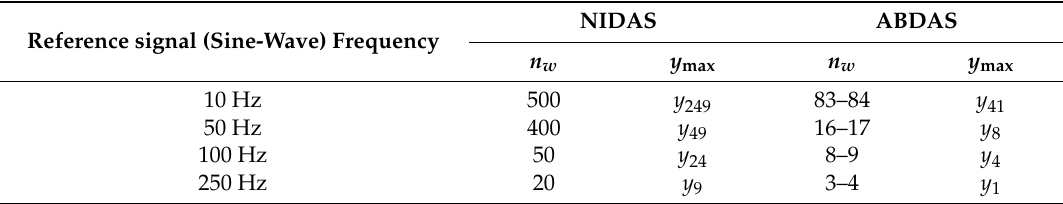
Table 4. Number of points, n w , measured by NIDAS and ABDAS in one single period of the reference signal, and highest Fourier harmonic term, y max , able to be correctly extracted.